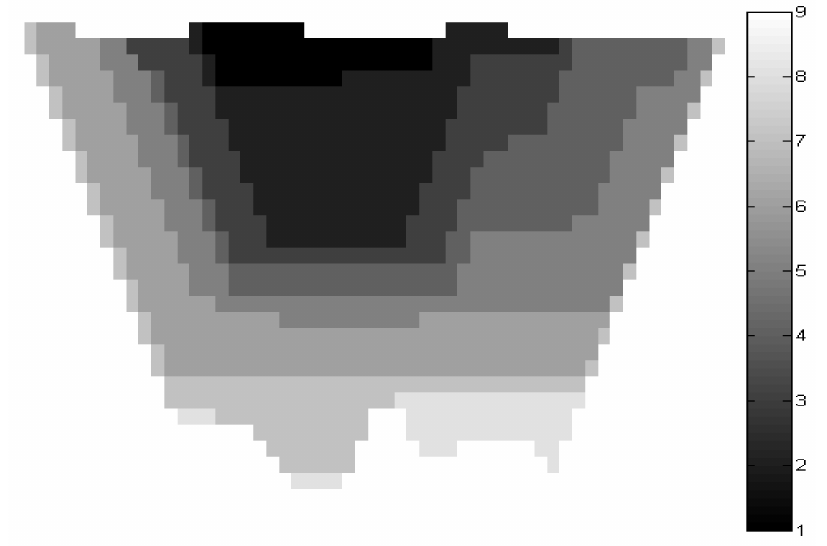
Figure 6. East–West section of the production schedule of the study mine using sequential branch- and-cut algorithm (color bar represents production period in